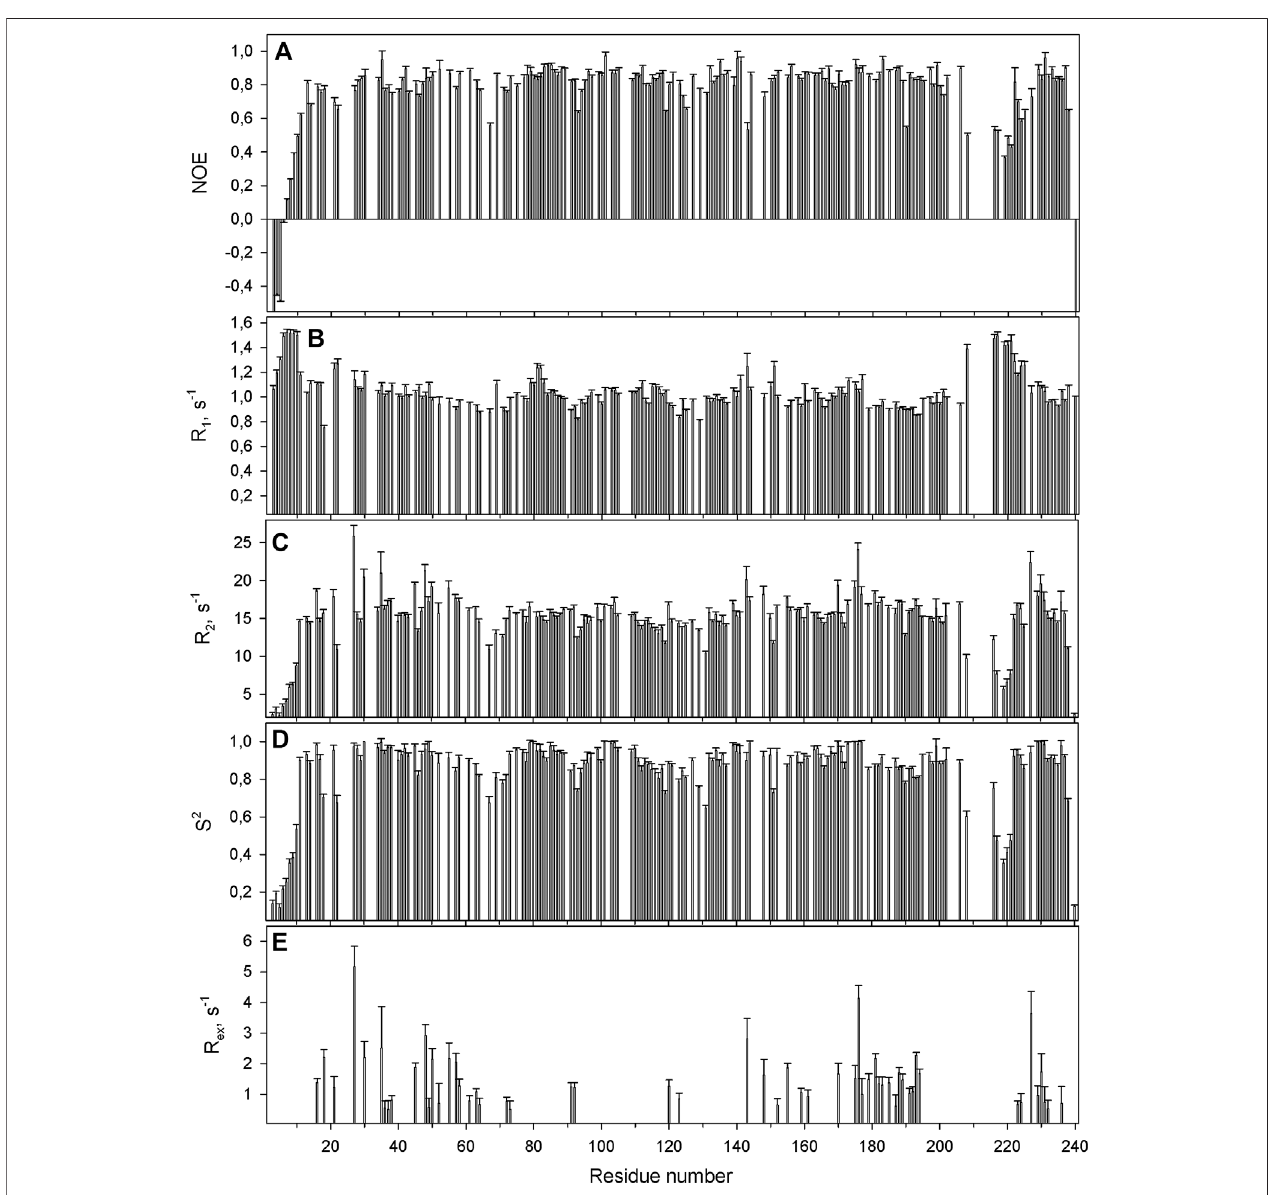
FIGURE 6 | The relaxation parameters of the amide 15 N nuclei of each residue of the SAH-WBSCR27 complex, measured at 16.3 T (700 MHz proton resonance frequency)and308 K. (A) Theheteronuclear 15 N, 1 H-steady-stateNOEvalues. (B) Thelongitudinalrelaxationrate R 1 (s − 1 ). (C) Thetransverserelaxationrate R 2 (s − 1 ). (D) The order parameter S 2 determined by model-free analysis. (E) Chemical exchange R ex contributions to the transverse relaxation rates (s − 1 ).